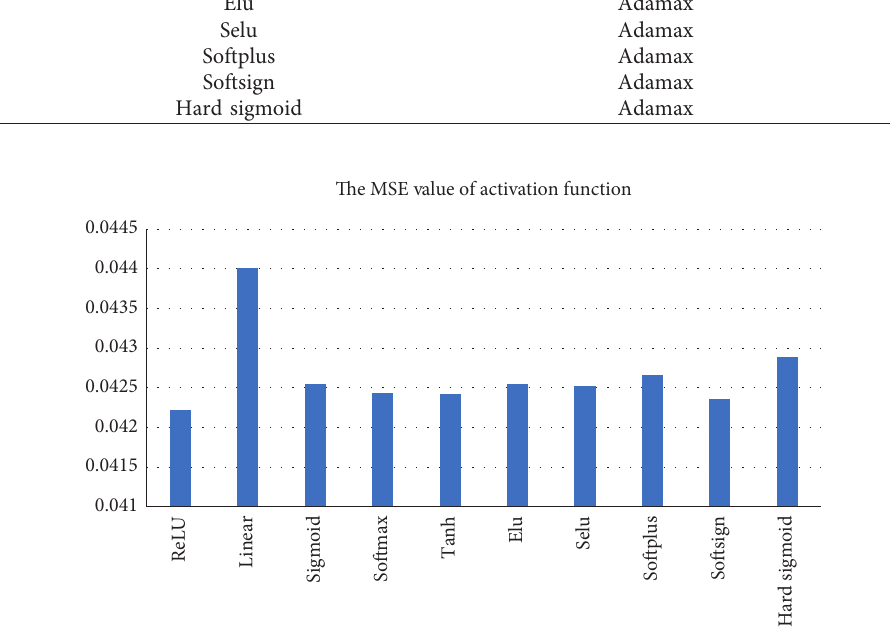
Figure 6: Visualization of activation function. Table 4: Neurons comparison.